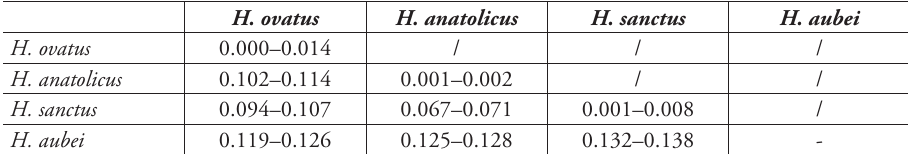
Table 4. Genetic distances between species calculated with Kimura 2-parameter model. Pairwise deletion of missing data was used, and the shortest fragment of H. sanctus (147bp) was deleted from comparison.